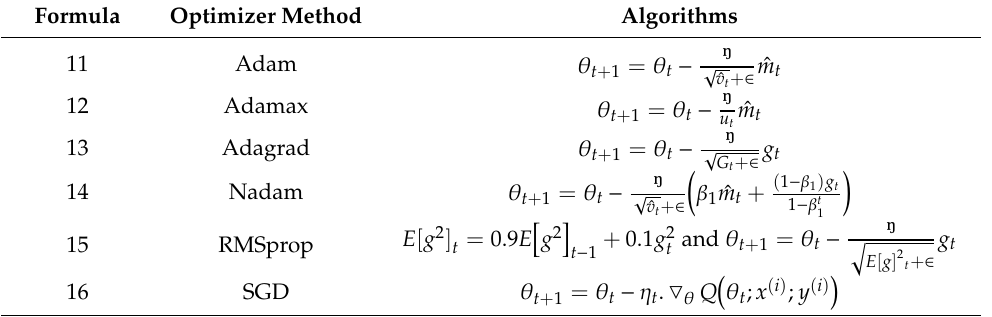
where θ is parameter value; ᵑ is the learning rates; t is time step; ∈ = 10-8; g (cid:2930) is the gradient; E[g]— moving average of squared gradients; m, v are estimates of first and second moments; u (cid:2930) —the max operation; β —moving average parameter (good default value—0.9); 𝜂 —step size.